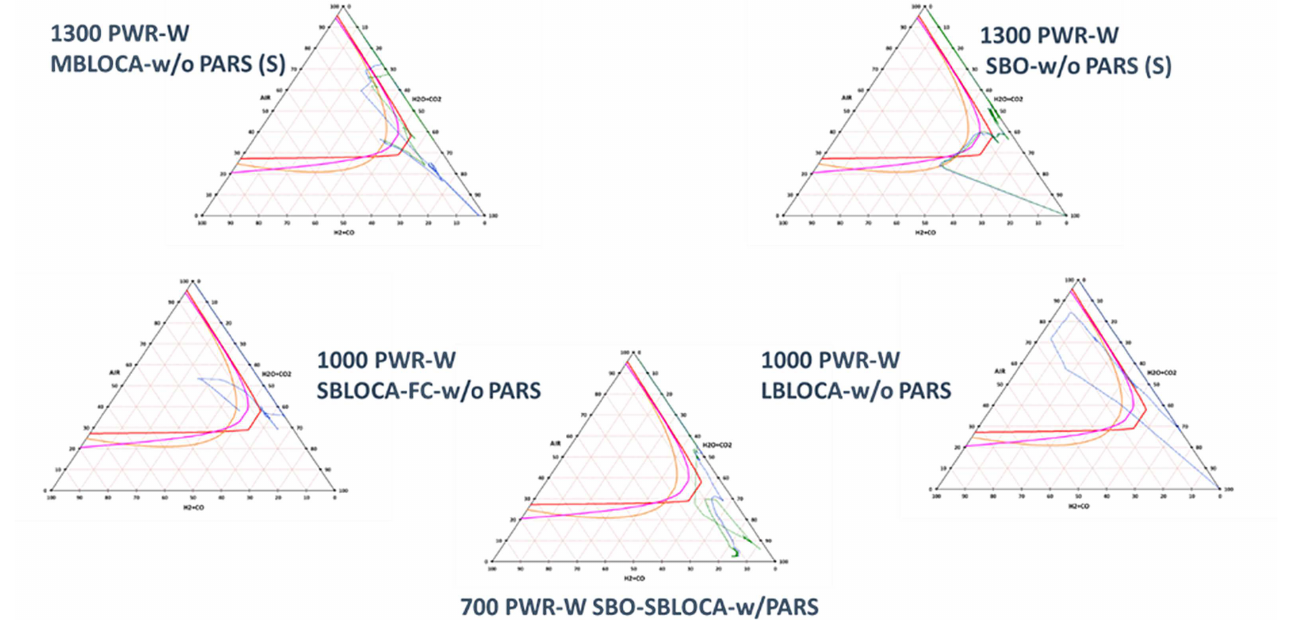
Fig. 10. Shapiro diagrams of the PWR-W accident sequences